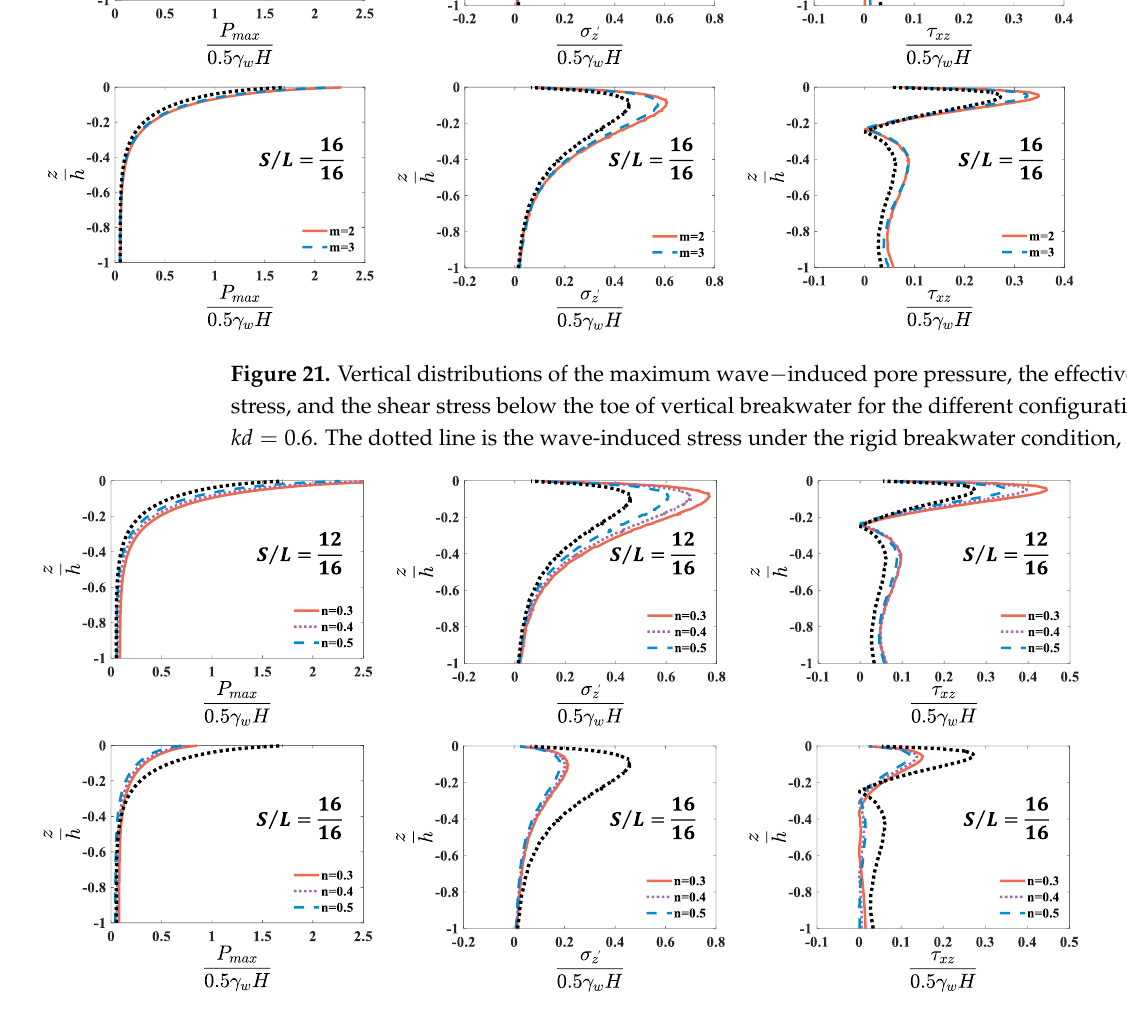
Figure 22. Vertical distributions of the maximum wave−induced pore pressure, the effective normal stress, and the shear stress below the toe of the vertical breakwater for the different porosities of three submerged breakwaters with 𝑘𝑑 = 0.6 . The dotted line is the wave-induced stress under the rigid breakwater condition, only.